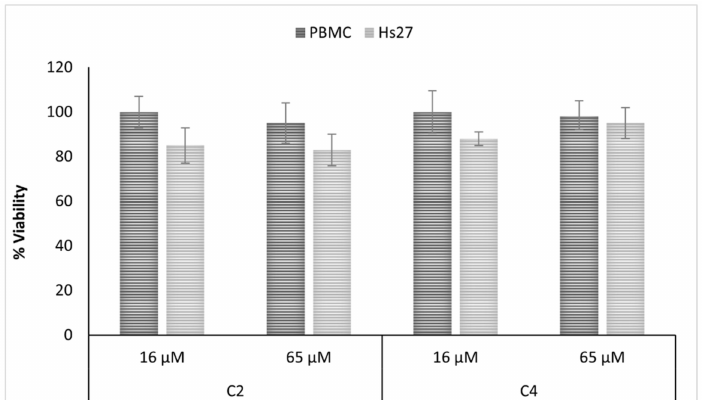
Figure 4. Evaluation of the cytotoxicity of uliginosin C (C2) and 3 (cid:48) prenyl uliginosin B (C4), measured using the WST-8 conversion assay, on normal human cell lines. The metabolic activity is given as the endpoint of toxicity in human peripheral mononucleate cells (PBMC) and human skin fibroblast cell line (Hs27), following 24 h exposure to the compounds. Values represent standard error of the mean ( n = 3). The results were analyzed by Student’s t -test. No statistically significant differences were